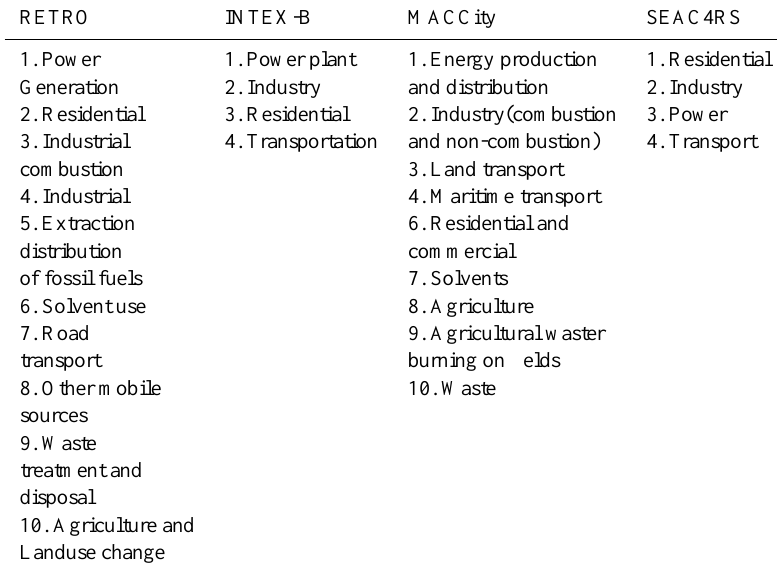
Table 1. Emission sectors used in the model simulations from each emission